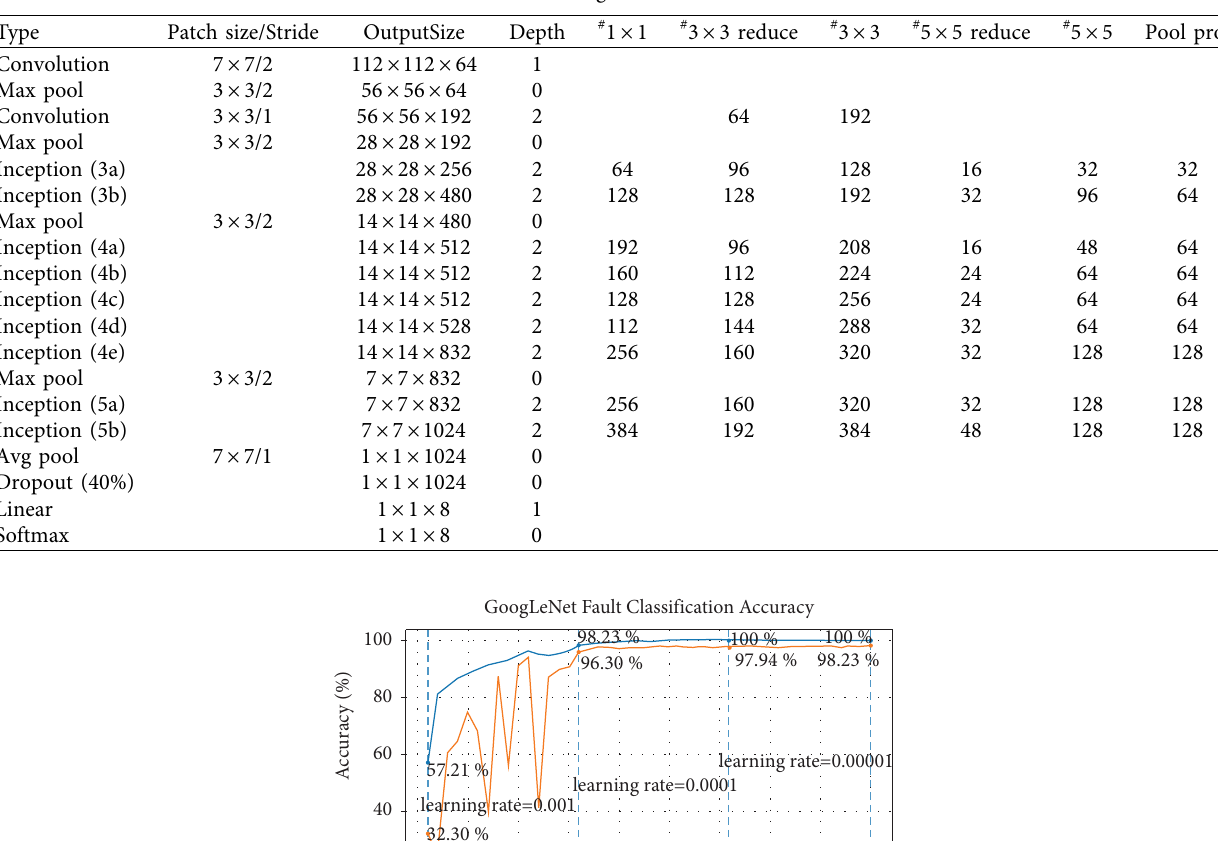
Figure 15: Preparation process of kurtograms dataset. Table 3: GoogLeNet structure.